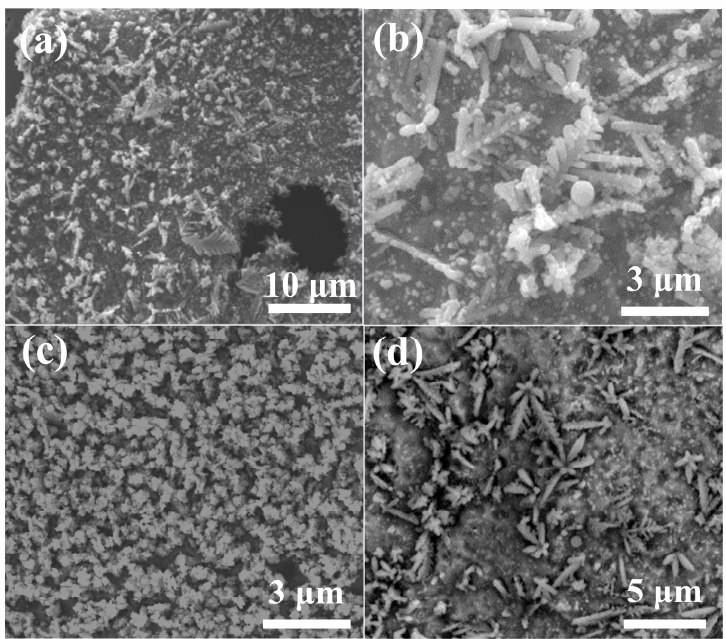
Figure 5. The surface morphology of a deposited flat NiCrBSi particle after acid corrosion. ( a ) low magnification image, ( b ) image at the back-scattering imaging mode, ( c ) near-spherical shape grains, and ( d ) ”fish bone-like” or “leaf-like” grains.